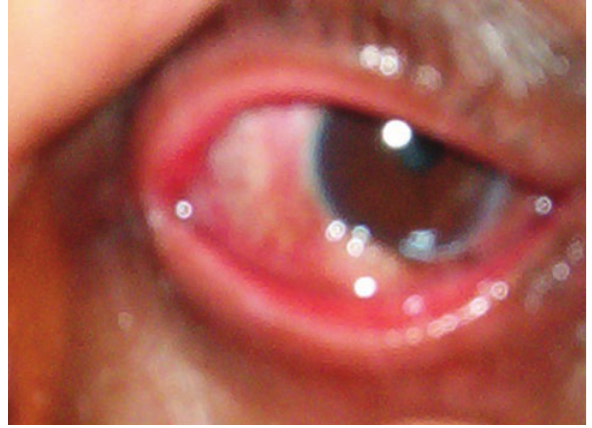
Figure 2. Subconjunctival mass right inferior fornix extending to